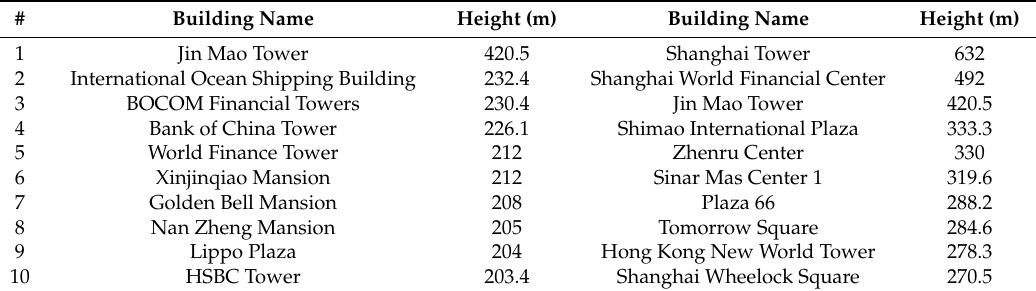
Figure 3. Shanghai in 2000 and 2020. Table 13. Shanghai’s 10 tallest skyscrapers in 2000 and 2020.